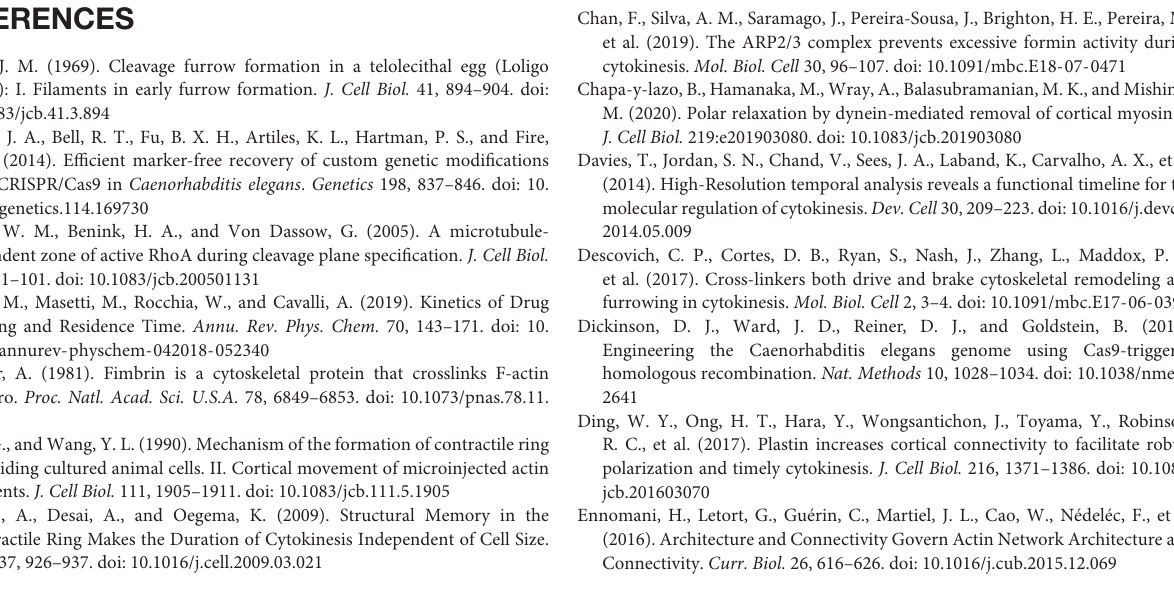
levels at the cortical poles and an increase at the cell equator. Scale bar, 5 µ m. (B) Quantification of NMY-2::GFP levels (mean ± SD) on the anterior pole, posterior pole, and equator at the time points indicated in (A) , determined as indicated in the schematic on the right. N is the number of embryos analyzed. SUPPLEMENTARY FIGURE S5 | Fluorescence recovery after photobleaching of the entire division plane indicates that myosin continues to accumulate in the contractile ring during furrow ingression. (A) Schematic showing the photobleached region of the entire division plane at shallow deformation (top left) and selected images from a time-lapse series showing NMY-2::GFP fluorescence over time pre- and post-bleaching. (B) Quantification of NMY-2::GFP fluorescence recovery after photobleaching the entire division plane at shallow deformation. Data from individual embryos (light gray) and the mean ± SD (black) are plotted. (C) Quantification of NMY-2::GFP fluorescence recovery after photobleaching in the posterior cytoplasm. (D) Boxplots showing the dispersion of half-time recovery for the posterior cytoplasm and the posterior cortex. In each box, the central line is the median, the boundaries of the box are the 25th and 75th percentiles; the whiskers extend to include the maximum and minimum values. N is the number of embryos analyzed. Statistical significance of half-time recovery in (D) was determined using unpaired Student’s t -test: ∗ P < 0.05. SUPPLEMENTARY FIGURE S6 | Cortical flows are not aggravated in nmy-2(RNAi) ; plst-1(prt89) embryos. (A) Kymographs of LifeAct::GFP cortical flow profiles along the longitudinal axis of the embryos. Yellow, red, and blue bars correspond to contractile ring assembly, furrow initiation, and ring constriction intervals, respectively. Kymographs were built as described in Figure 1D ’. (B) Cosine similarity between two vectors as a function of the distance between them. (C) Longitudinal (X-component) average flow velocity (mean ± SEM) over time after anaphase onset for LifeAct::GFP in the anterior or posterior half of the embryos. Arrows indicate the time of shallow deformation. In panels (B), (C), N is the number of embryos analyzed. SUPPLEMENTARY TABLE S1 | List of C. elegans strains used in this study. SUPPLEMENTARY TABLE S2 | List of dsRNAs used in this study. SUPPLEMENTARY MOVIE S1 | Plastin and myosin cooperate to align F-actin bundles at the division plane. Time-lapse series of the cell cortex in dividing one-cell embryos of the indicated genotypes expressing LifeAct::GFP and NMY- 2::mCherry. Cortical images are maximum intensity projections of seven